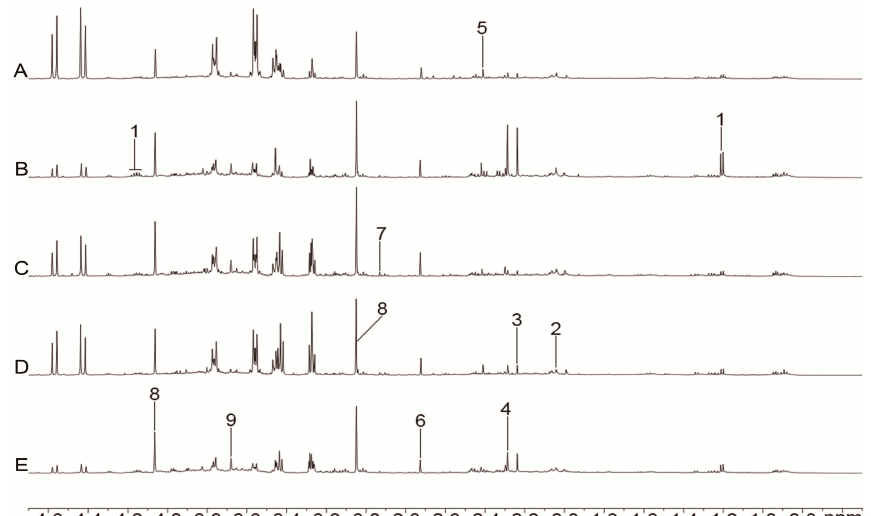
Figure 4. Representative 1 H-NMR spectra (0.5–4.7 ppm) of urine for the control ( A ), model ( B ), nimodipine ( C ), H-TCNDS ( D ), and L-TCNDS ( E ) groups. Key metabolites: 1.